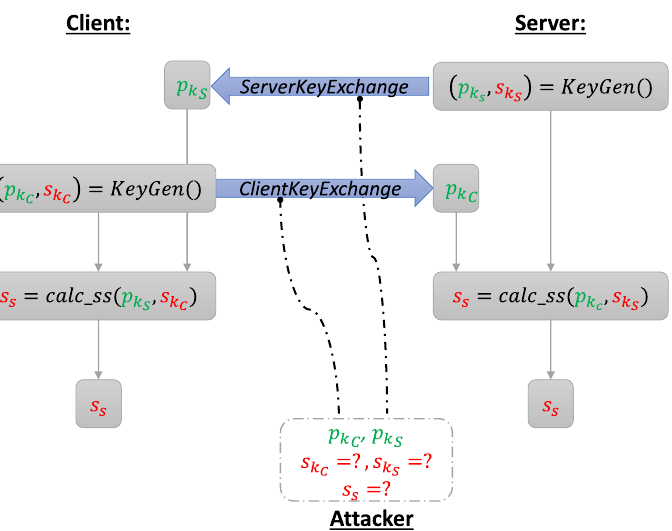
Figure 2. ECDHE working principal in the TLS 1.2 handshake: respectively, p k public key of client and server, s k The green-marked variables may be publicly known while the red ones have to remain